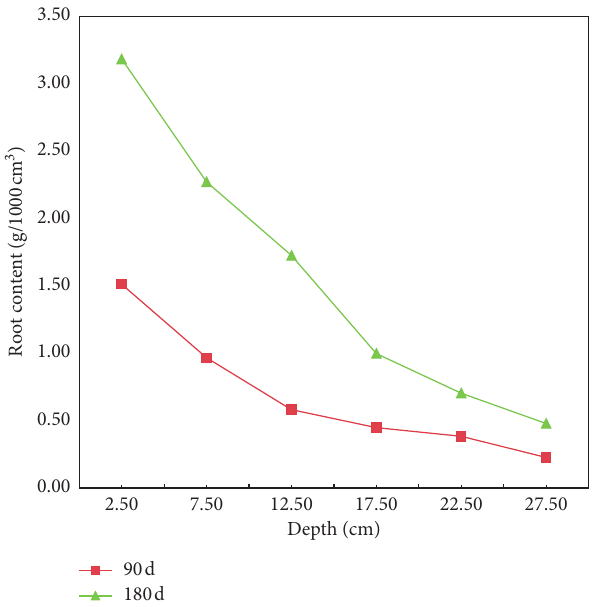
Figure 6: Root rate change trend with